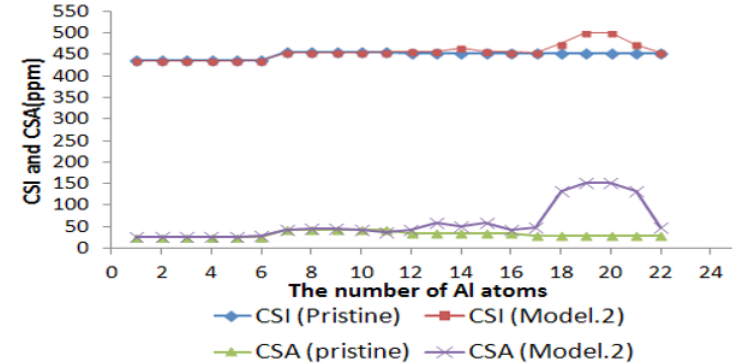
Figure 10. The NMR parameters for the 27 Al atoms of O-decorated (10, 0) zigzag AlNNT